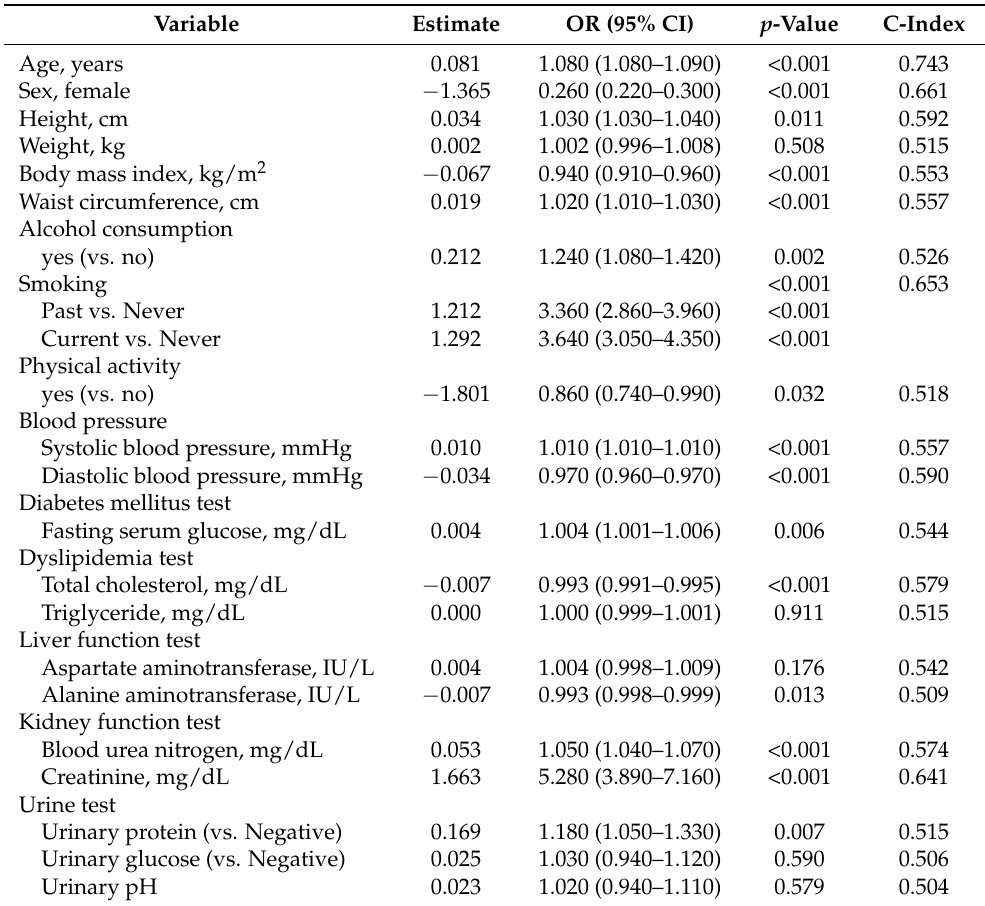
Table 2. Univariable analyses of variables involved in the health examination for COPD in the training